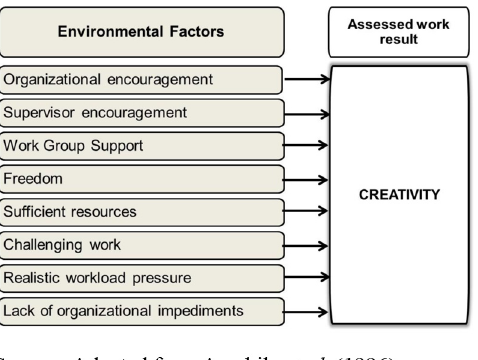
Figure 2. Environmental